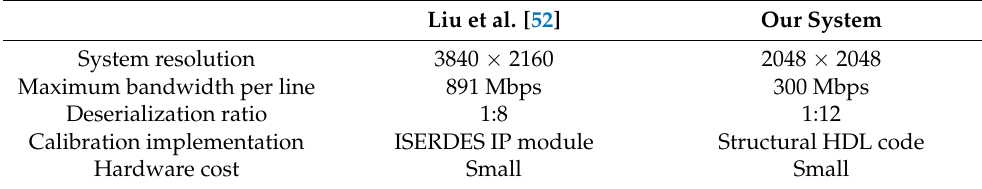
Table 4. Comparison of systems using the Artix-7 FPGA deserializer.